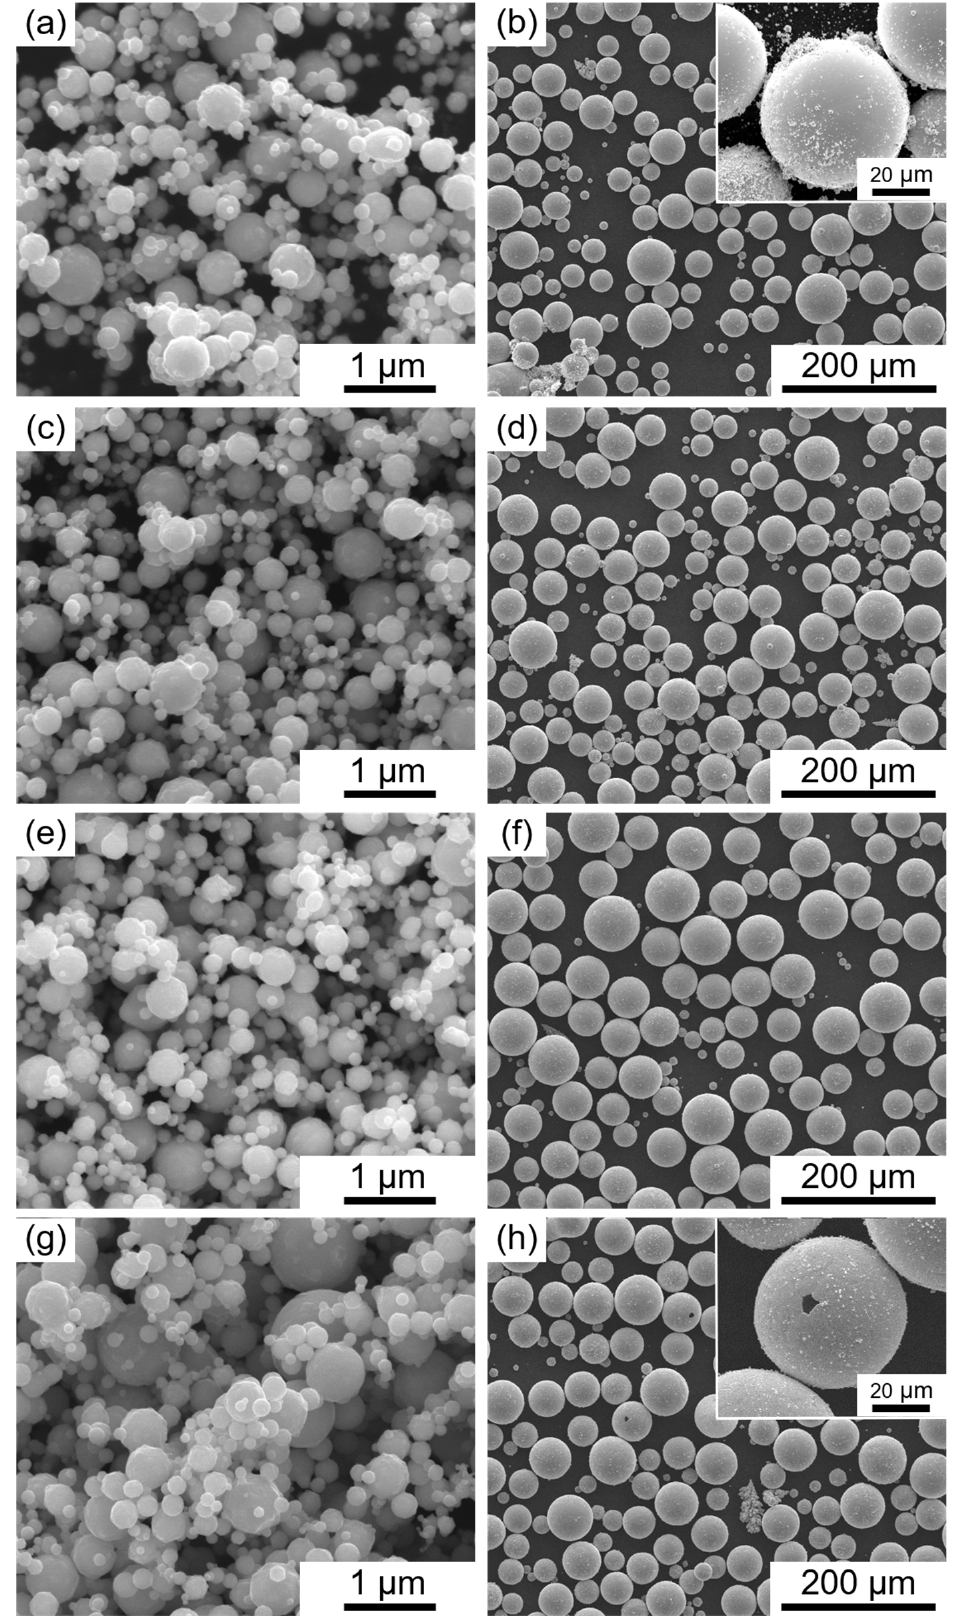
Figure 4. SEM images of the NP-powder and CS-powder with different carrier gas flow rates: ( a ) and ( b ) 4 L/min, ( c ) and ( d ) 5 L/min, ( e ) and ( f ) 6 L/min, ( g ) and ( h ) 7 L/min.